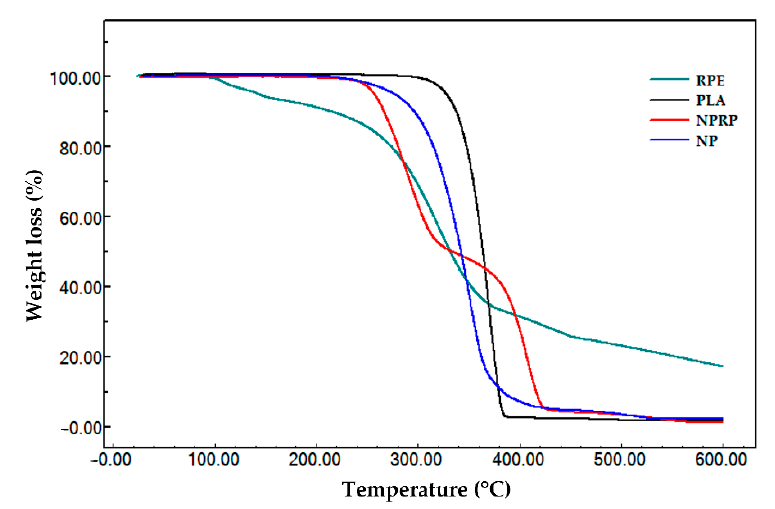
Figure 6. Thermogravimetric profile of red propolis extract, PLA, NPs, and NPRP. Event I had an initial event beginning at 88.8 °C and ended at a final temperature of 118.8 °C. It was characterized by the output of water (5.9%) adsorbed on the hydroalco- holic extract of propolis. The second event started at 278.0 °C and ended at 353.4 °C. It may be related to the degradation of phenolic compounds. Event III was marked by an initial temperature of 427.4 °C and a final temperature of 503.6 °C, indicating the emer- gence of products generated during the thermodegradation process that need to be sub- jected to higher temperatures for mass loss to occur. The thermogravimetric curve ob- tained in the NPs’ analysis revealed a profile with high thermal stability, like that found for pure PLA (Table 5). The nanoparticles loaded with red propolis presented two ther- mal events. The first event showed a reduction in the stability of the polymer after the incorporation of propolis, and the second revealed a loss of mass in the thermodecom- position of PLA and the major components of red propolis. Table 5. Thermogravimetric events of RP, PLA, NP, and NPRP. Sample